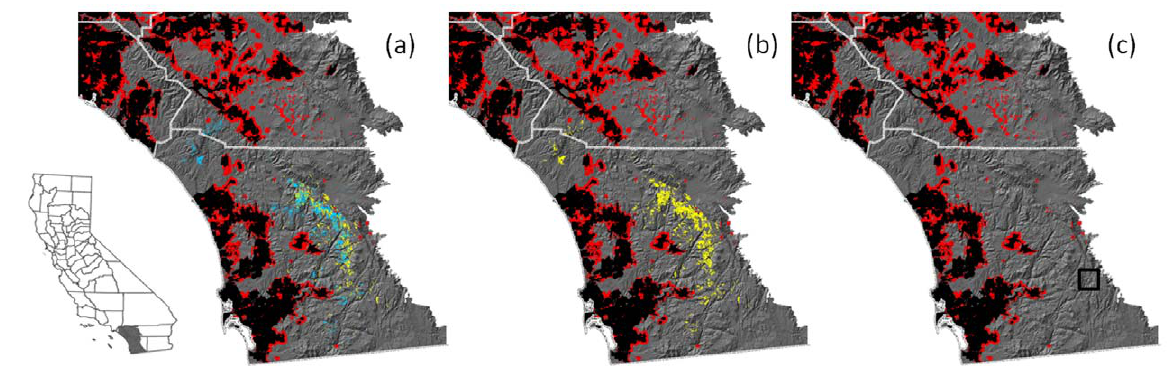
Figure 1. Map of the study area: most of San Diego and Orange Counties, western Riverside County, and the southern corners of Los Angeles and San Bernardino Counties (see inset). Map (a) shows habitat currently occupied by Q. engelmannii in cyan, and other habitat estimated to be currently suitable in yellow. Map (b) shows predicted 2100 suitable habitat in yellow for the PCM future climate scenario. Map (c) shows the same for the GFDL scenario (the box in the lower right surrounds the two small patches of remaining suitable habitat). In all three maps, the black represents current urban areas, and the red represents the extent of urban expansion by 2050.